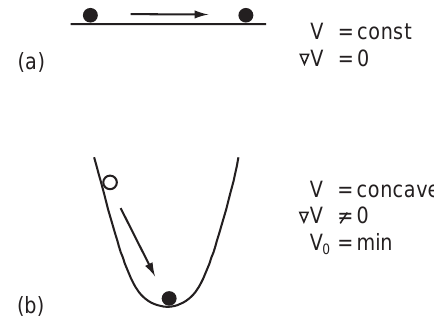
V = 0 and ∇ 2 V > 0. o of a concave potential with ∇ V = 0; (b) asymptotic stability at a critical point ∇ V = 0. ∇ (cid:4)